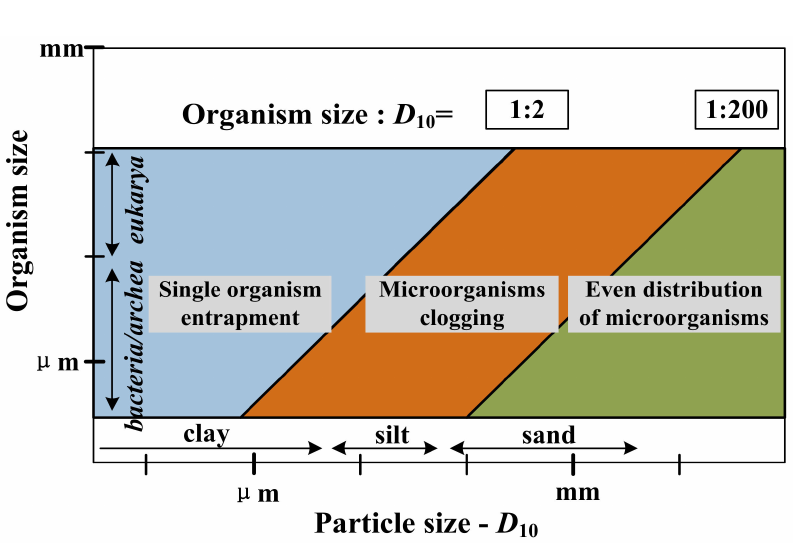
Figure 12. The relationship between microorganism size and soil particle size for even distribution (Modified from